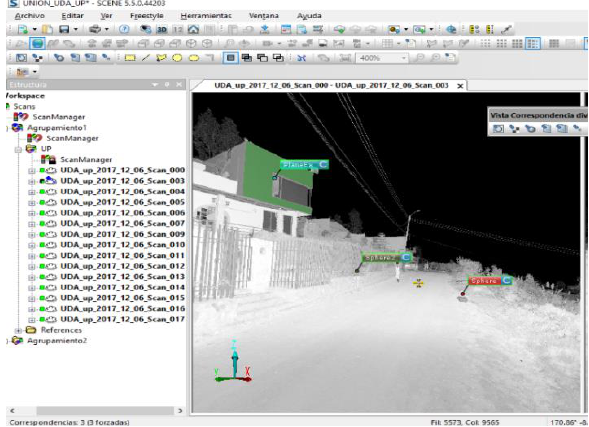
Figure 2. Union of point clouds of LiDAR using the FARO SCENE Software.